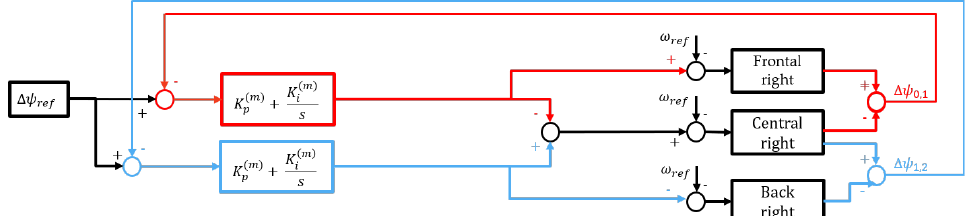
Figure 18. Block diagram of the control algorithm correcting the phase shift between mechanisms of the same fin.